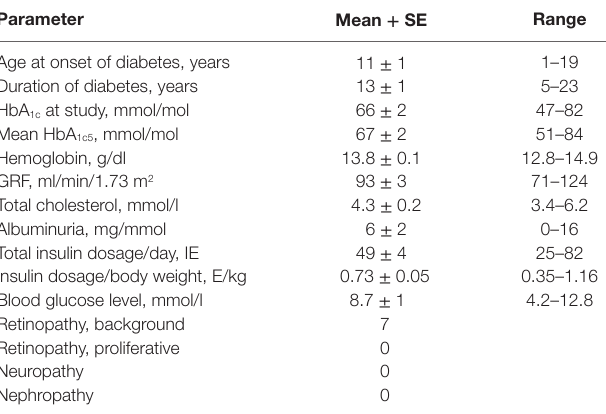
TaBle 1 | characteristics of women with type 1 diabetes.